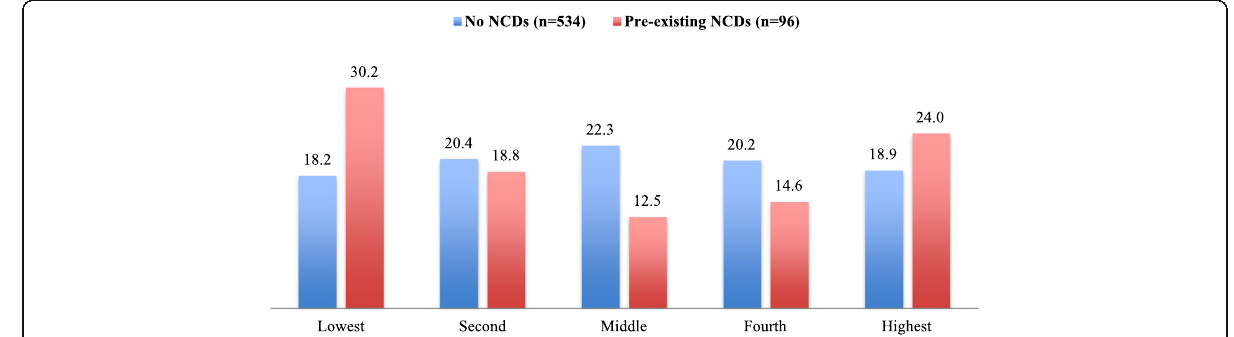
Fig. 1 Prevalence of pre-existing NCDs among pregnant women with different wealth quintiles ( n =